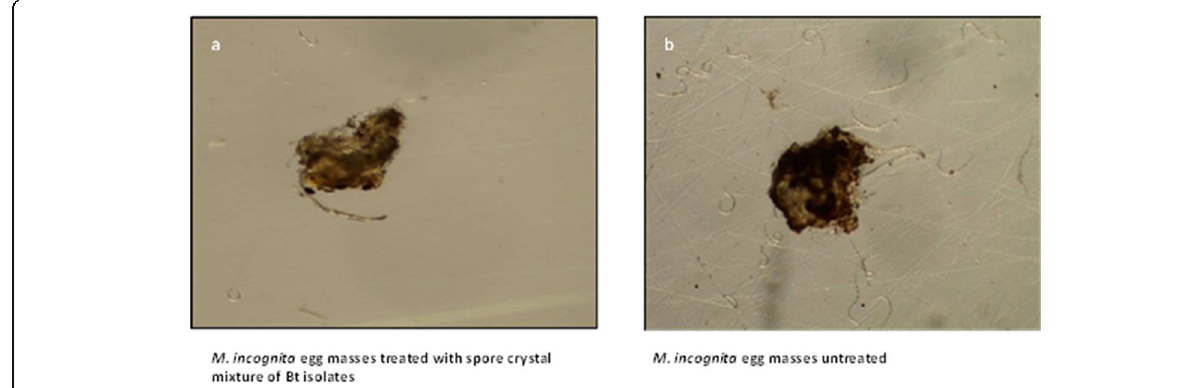
Fig. 3 In vitro inhibition of emergence of J2 juveniles from egg masses of Meloidogyne incognita by spore-crystal mixture of native Bacillus thuringiensis isolates. a Unhatched egg masses of M. incognita treated with spore-crystal mixture. b Release of J2 juveniles in untreated egg masses of M.